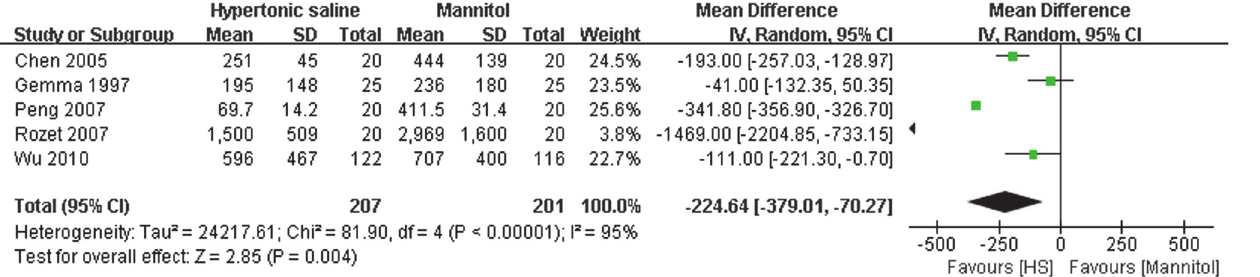
Fig 5. Diuretic output during neurosurgery in HS and mannitol groups. IV: Inverse Variance.